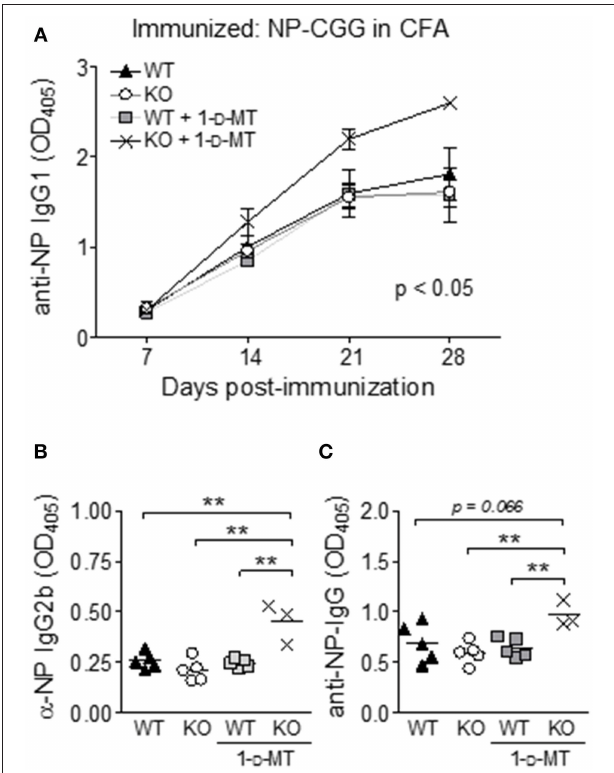
FIGURE 4 | IDO suppresses antibody responses to an exogenous T-dependent antigen in B6.Nba2 mice. B6.Nba2 and B6.Nba2.IDO − / − were left treated or not with 1- D -MT after immunization with 20 µ g NP-CGG conjugate in Complete Freund’s Adjuvant (CFA). (A) The data display the mean ± SEM of anti-NP IgG1 levels in serum obtained from three separate rounds of immunization; B6.Nba2 ( n = 5), B6.Nba2 + 1- D -MT ( n = 5), B6.Nba2.IDO1 − / − ( n = 5), B6.Nba2.IDO1 − / − + 1- D -MT ( n = 3). (B,C) Serum IgG2b and total IgG levels 28 days post immunization. Each symbol represents one mouse. ** p < 0.01. Two-way ANOVA (A) or Student’s unpaired t -test with Welch’s correction (B,C)